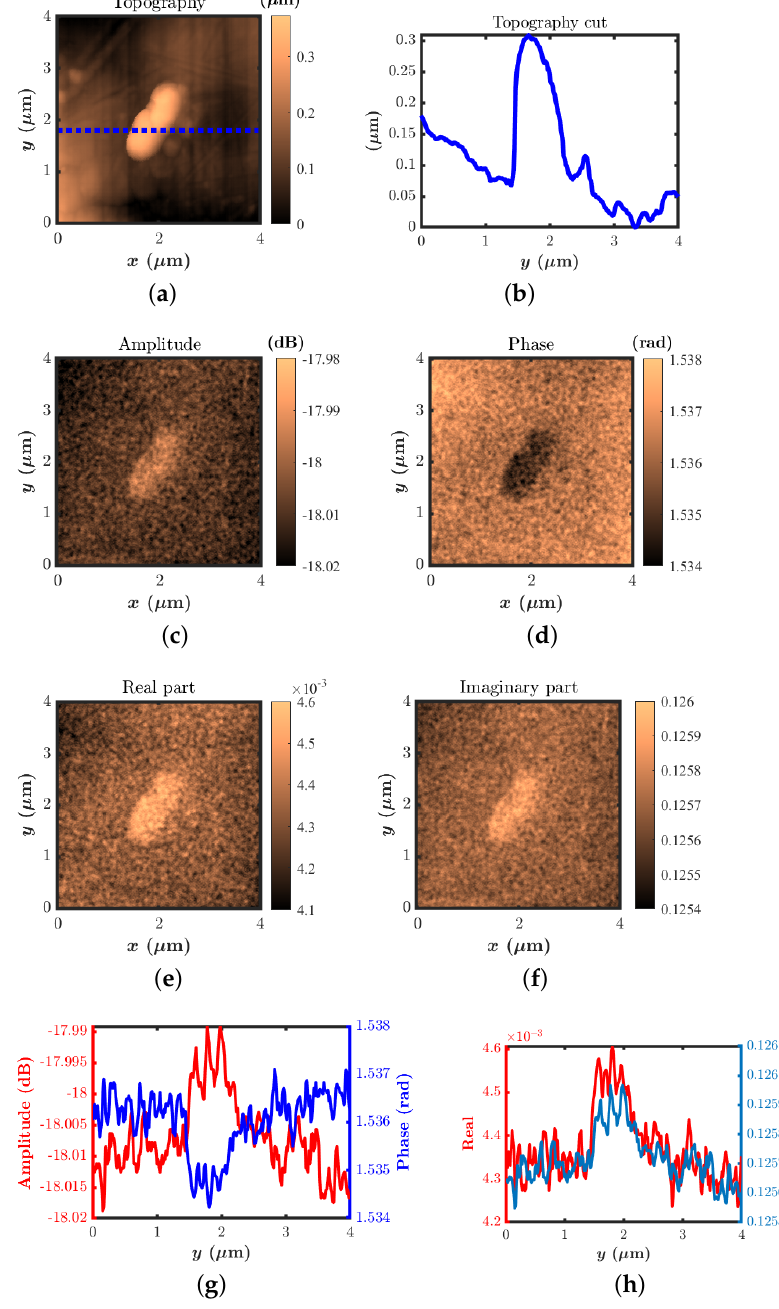
Figure 7. ( a ) AFM topography. ( b ) Line profile of the AFM topography along the dotted line shown in the topography image. Frequency-domain images of S 11 obtained at 5.99 GHz. ( c ) Amplitude, ( d ) phase, and ( e ) real part of S 11 ; ( f ) imaginary part of S 11 . Corresponding line profiles along the same cross-section as that in the topography ( g , h